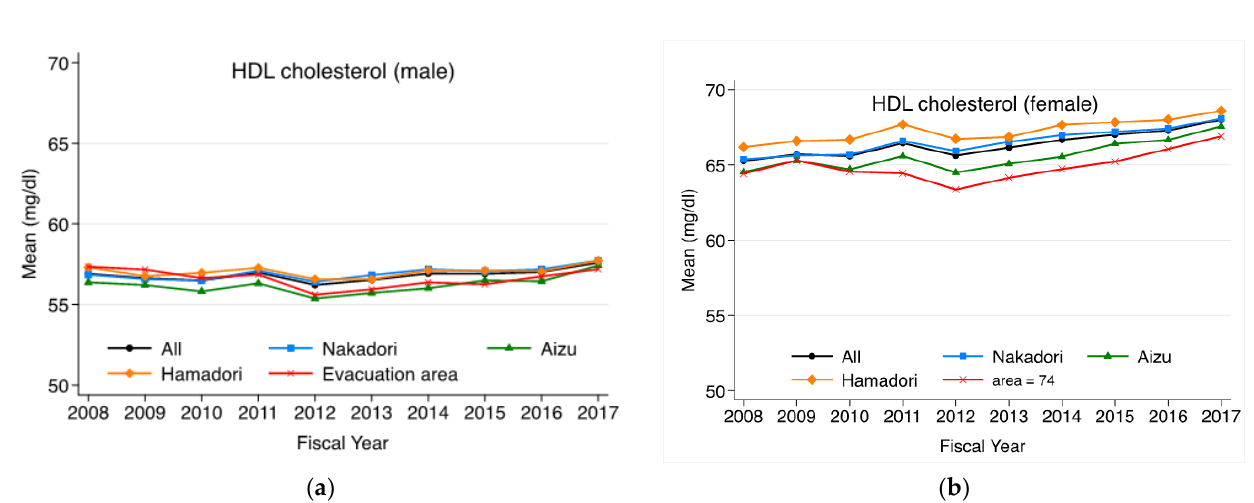
Figure 4. ( a ) Annual trends in age-adjusted mean HDL cholesterol levels for males in each region. ( b ) Annual trends in age-adjusted mean HDL cholesterol levels for females in each region. In addition to the four regions, trends for Fukushima Prefecture as a whole are also shown.